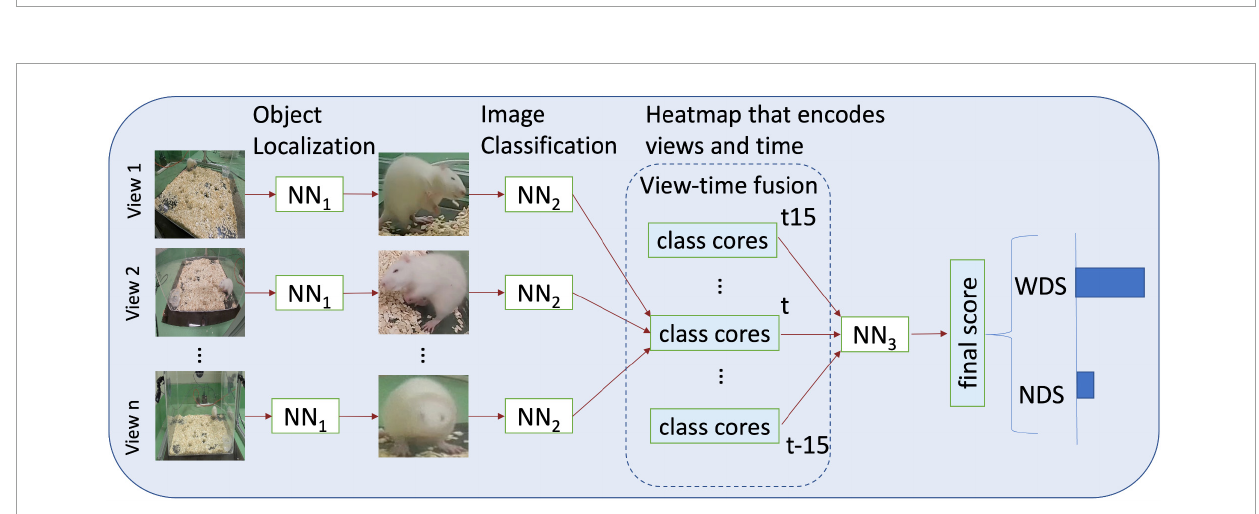
FIGURE4 An overview of the method used and the different stages. NN1 object localization; NN2 image classification; NN3 predicts the final score from a feature map encoding time and the